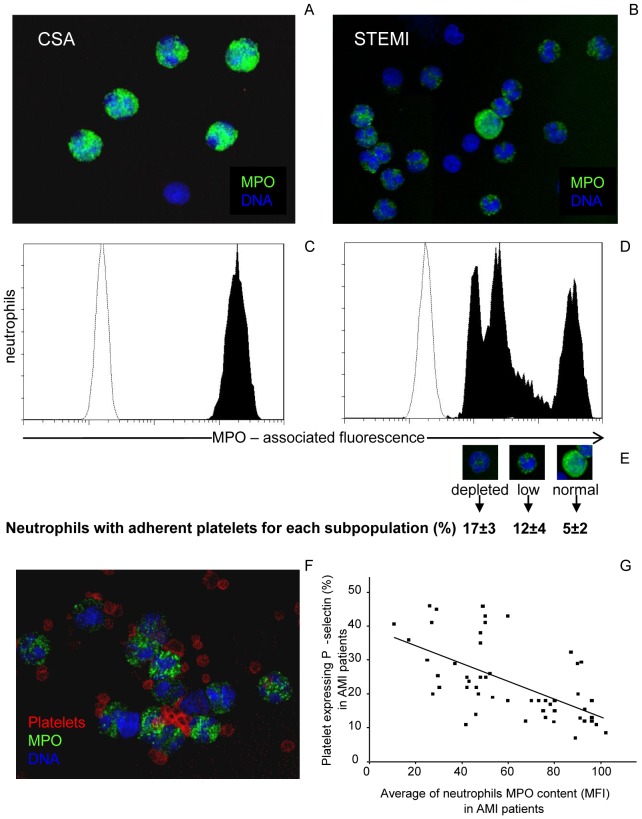
Heterogeneity of myeloperoxidase content in circulating neutrophils from patients with acute myocardial infarction is associated to platelet adhesion and activation.Intracellular MPO content in circulating neutrophils and platelet-neutrophil heterotypic aggregates were evaluated in whole blood samples by four-color flow cytometry. Venous blood samples were obtained within the first 6 hours of onset of symptoms. For confocal determinations, monoclonal antibodies against MPO were labeled with Alexa Fluor 488 (green) and against platelet glycoprotein Ib with Alexa Fluor 546 (red). Hoechst (blue) was used for counterstaining of nuclei. Panel A. Representative confocal images illustrate the MPO (green) content observed in circulating neutrophils of a patient with chronic stable angina. Panel B. Representative confocal images illustrate the heterogeneity in the MPO (green) content observed in circulating neutrophils of a patient with acute myocardial infarction. Panel C-D. The cytofluorimetric histogram shows the trimodal pattern MPO-associated distribution (black) in AMI but not in CSA, vs isotype control (white). Panel E: confocal images of neutrophils with complete MPO depletion, low or normal MPO content. Results are the mean value ± SEM of heterotypic aggregates observed in each neutrophil subpopulation. Panel F: confocal microscopy of aggregates between platelet (red) and degranulated neutrophils from a representative patient with AMI. Panel H. Correlation analysis indicates the association between platelet activation and neutrophil myeloperoxidase content in patients with AMI: platelet P-selectin expression (% of CD61+ cells, y axis) are plotted against the neutrophil intracellular MPO content (MFI-within CD66b+ cells, x axis; R = 0.6, P<0.0001).